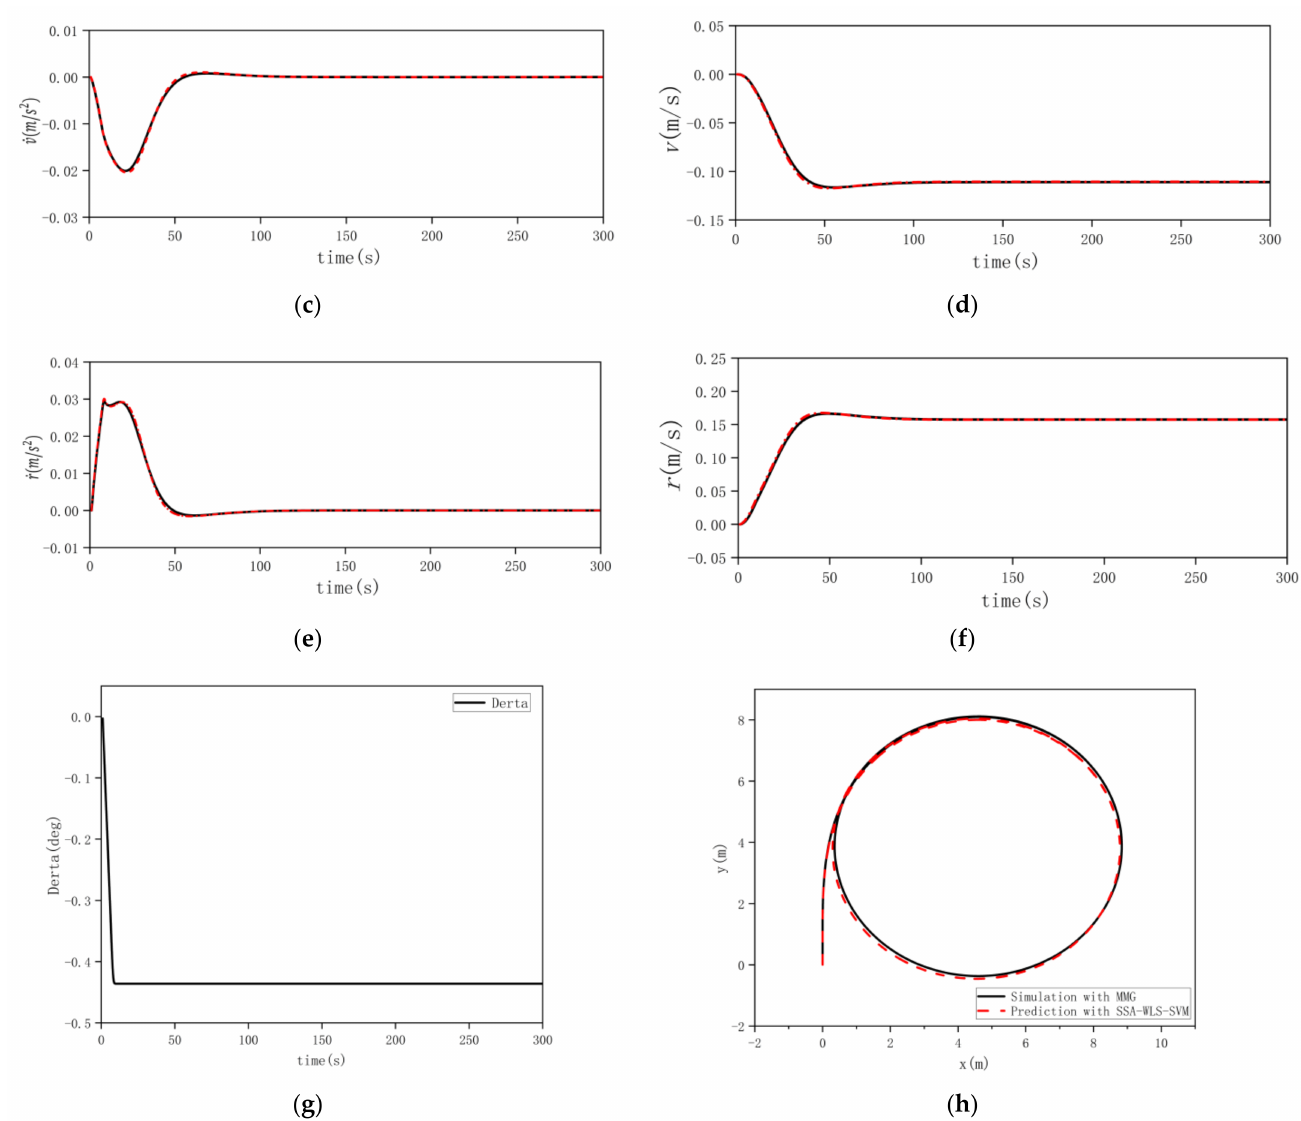
Figure 14. Comparison of the prediction with SSA-WLS-SVM and simulation of the 25 ◦ turning maneuvering motion. ( a ) Longitudinal acceleration. ( b ) Longitudinal velocity. ( c ) Lateral acceleration. ( d ) Lateral velocity. ( e ) Steering angular acceleration. ( f ) Steering angular speed. ( g ) Rudder angle. ( h ) Track of